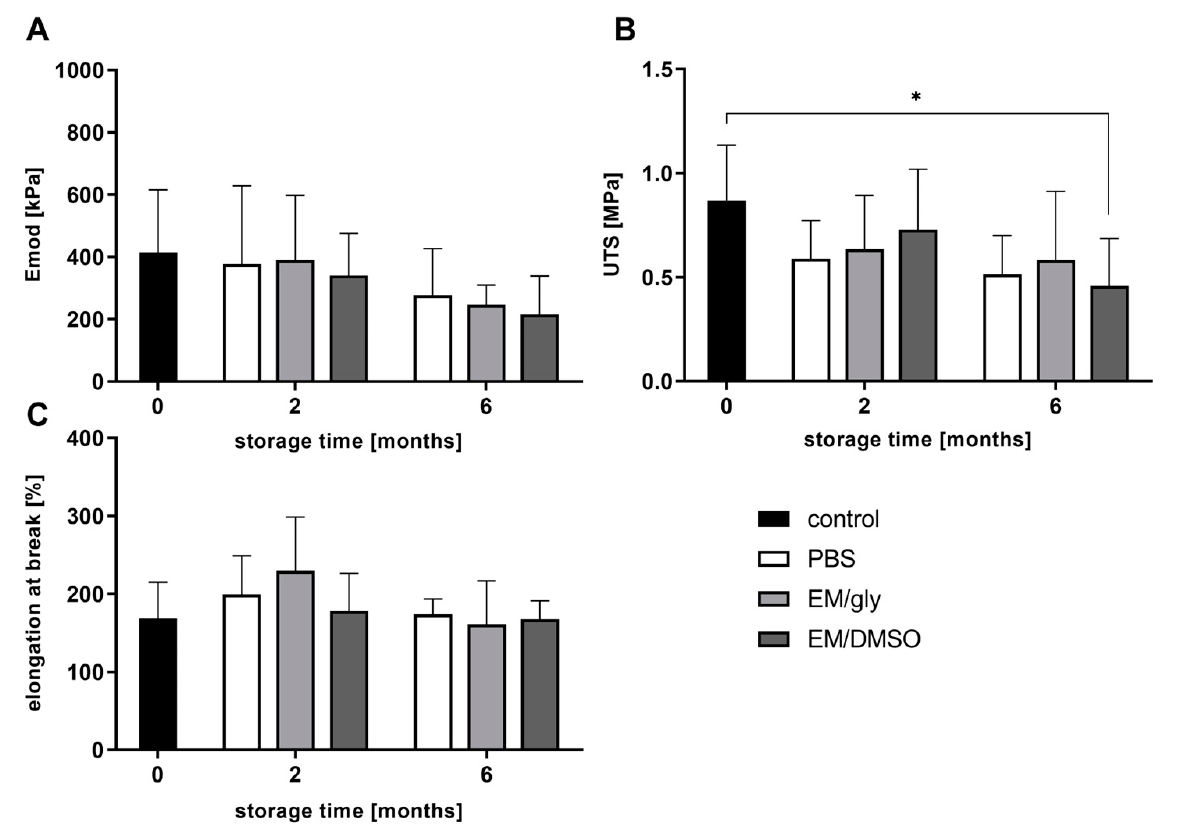
Figure 4. Biomechanical properties of fresh PDC (control) and PDC stored for two and six months in PBS (at 4 °C), in EM/gly (at − 80 °C) and in EM/DMSO (at − 196 °C). While the elastic modulus ( A )